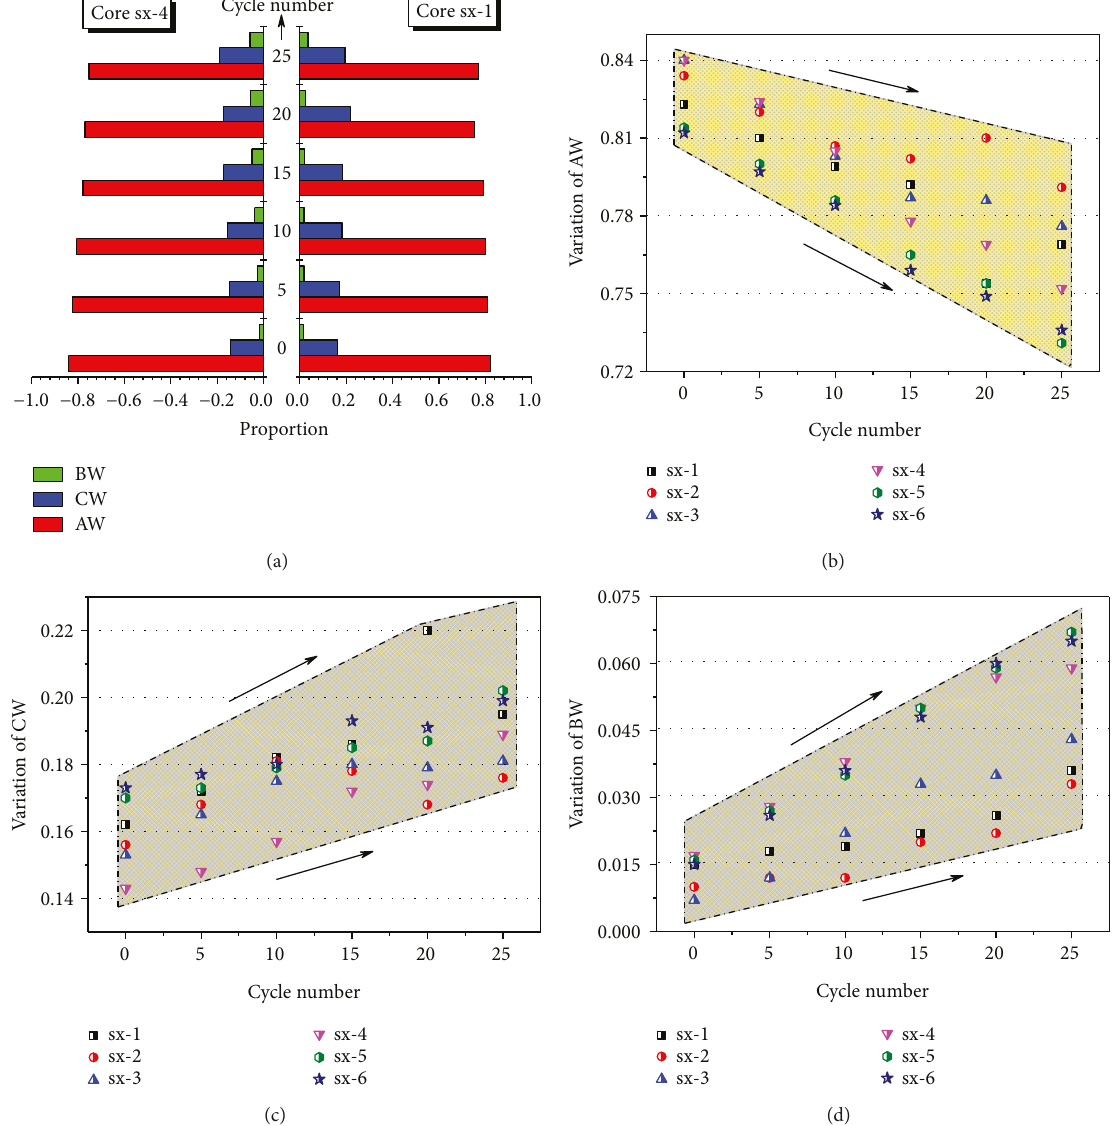
Figure 5: Changes of AW, CW, and BW for di ff erent cores: (a) proportion of AW, CW, and BW for cores sx-1 and sx-4; (b), (c), and (d) mean the variations of AW, CW, and BW, respectively, with increasing cycle